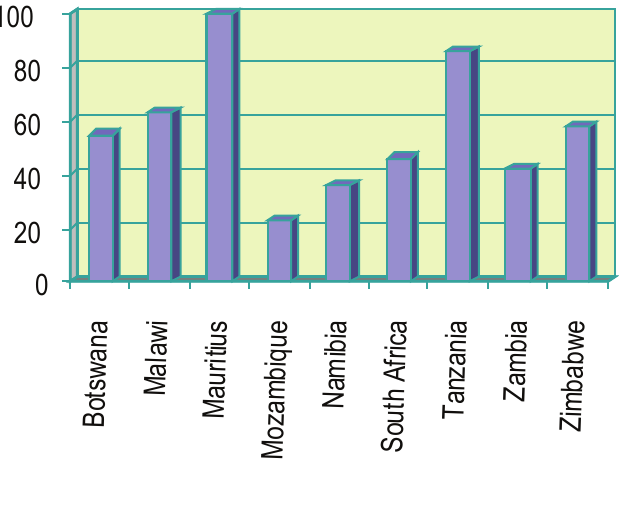
Figure 1: Southern Africa regional access to sanitation,